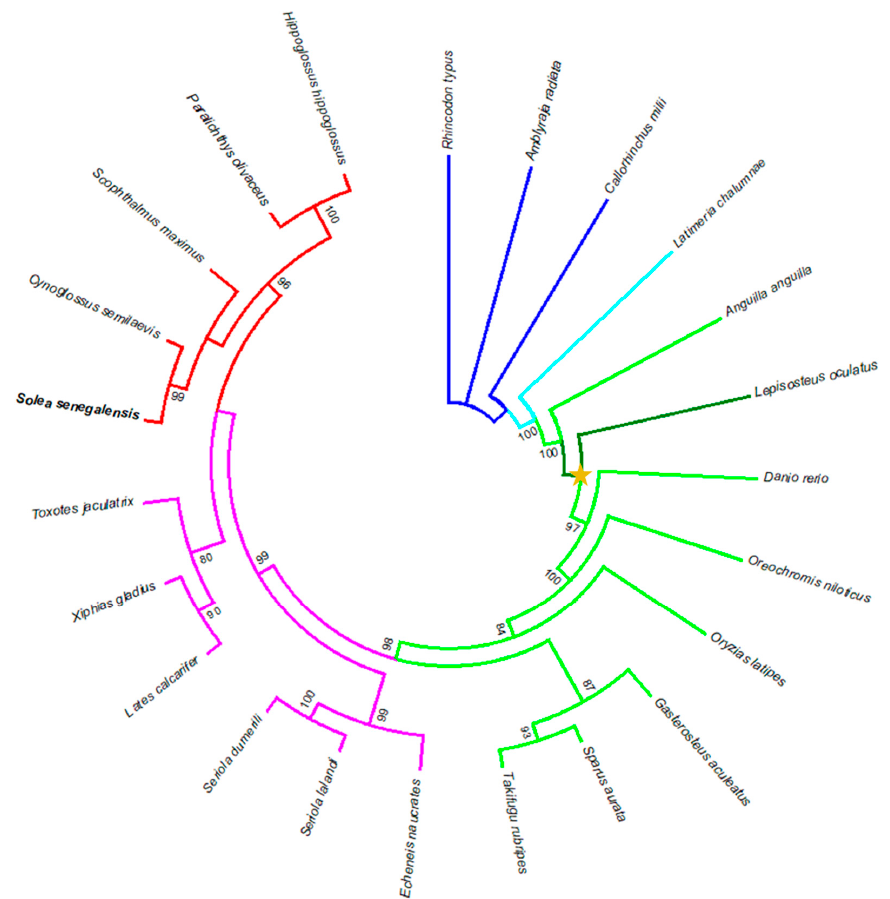
Figure 6. Phylogenetic tree constructed from the hoxba cluster ( hoxb1a , hoxb3a , hoxb6a , hoxb9a , and hoxb13a ) of twenty-two species. Blue lines: Chondrichthyes lineage; cyan lines: Sarcoptherygii lineage; dark green lines: non-Teleostei Actinopterygii lineage; pale green + pink + red lines: Teleostei lineage; pink + red lines: Carangaria lineage; and red lines: Pleuronectiformes lineage. Yellow star denotes the teleost-specific genome duplication (TSGD) event.